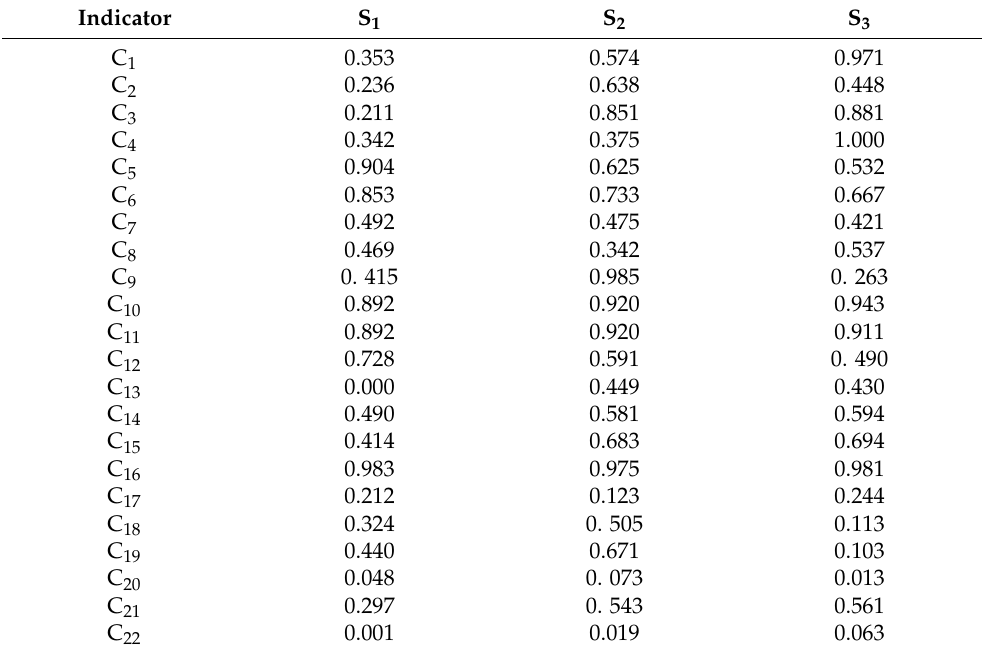
Table A3. Dimensionless